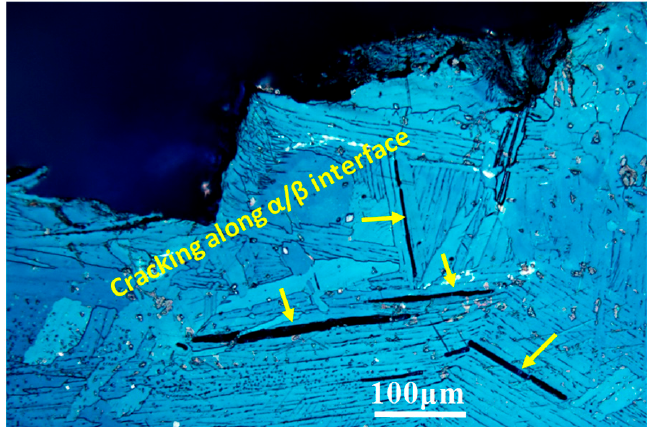
Figure 9. The cracks propagate along the α / β interface in CG Ti sample during impact deformation.